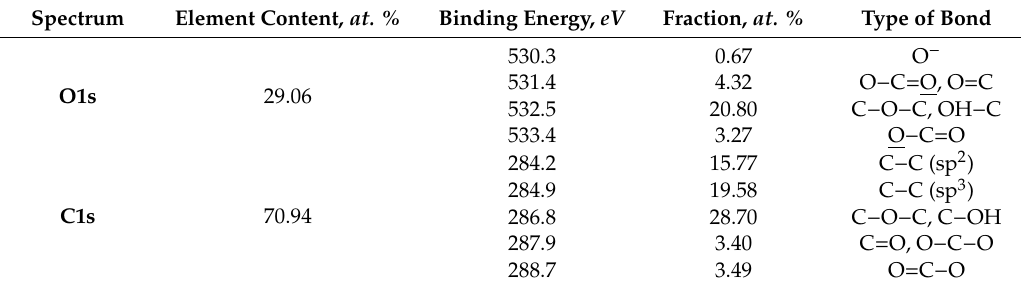
Table 3. Element concentrations, binding energies and component fractions for the light sample.